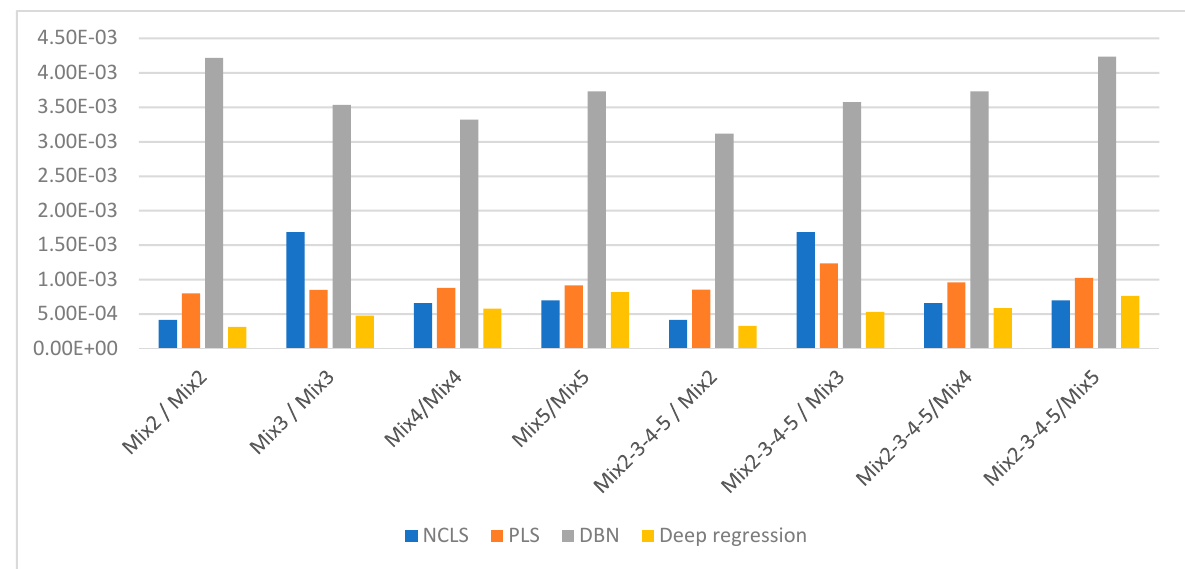
Figure 10. Average RMSE comparison using bar plots for “low ‐ mixing ‐ rate mixture” dataset with respect to case (Mixing ‐ rate range used for synthesizing mixtures is: [10 − 3 10 − 1 ], Min: 10 − 3 Max: 10 − 1 ).